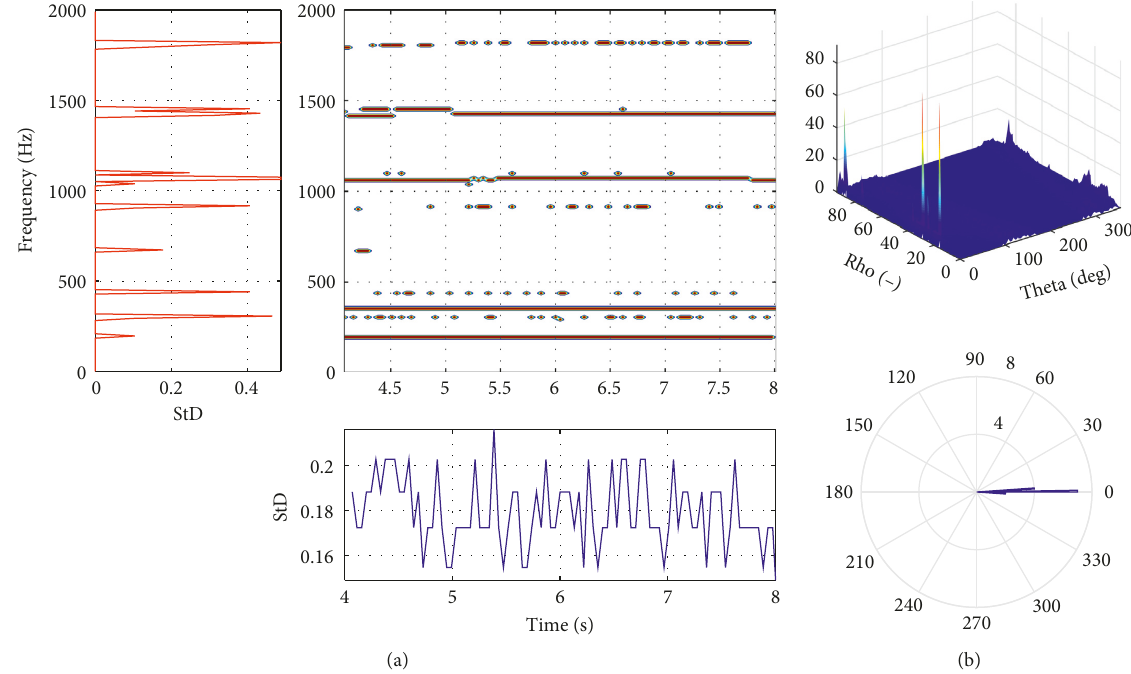
Figure 12: Time-frequency standard deviations (a) and HTdiagram with relevant theta’s polar histogram (b) of the peaks diagram (cropped within effective milling time range) of bed frame acceleration, for the third